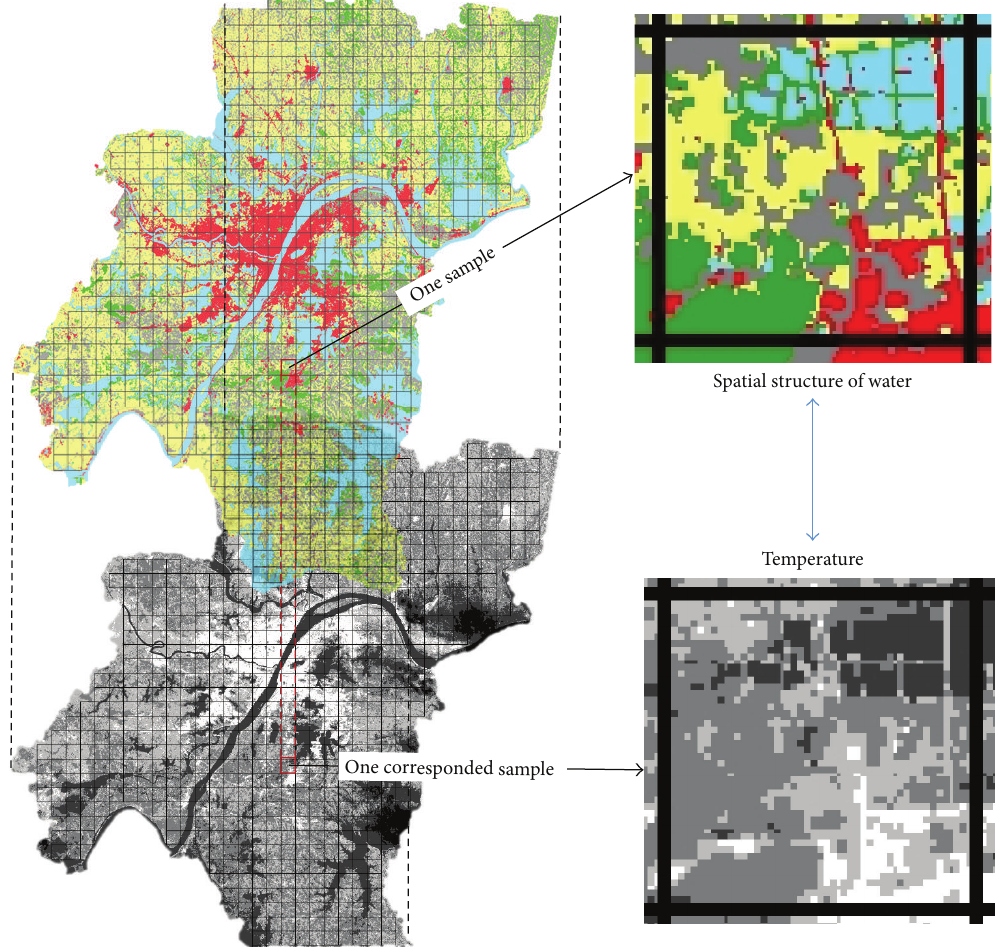
Figure 4: Water spatial structure and its corresponding mean temperature in sample